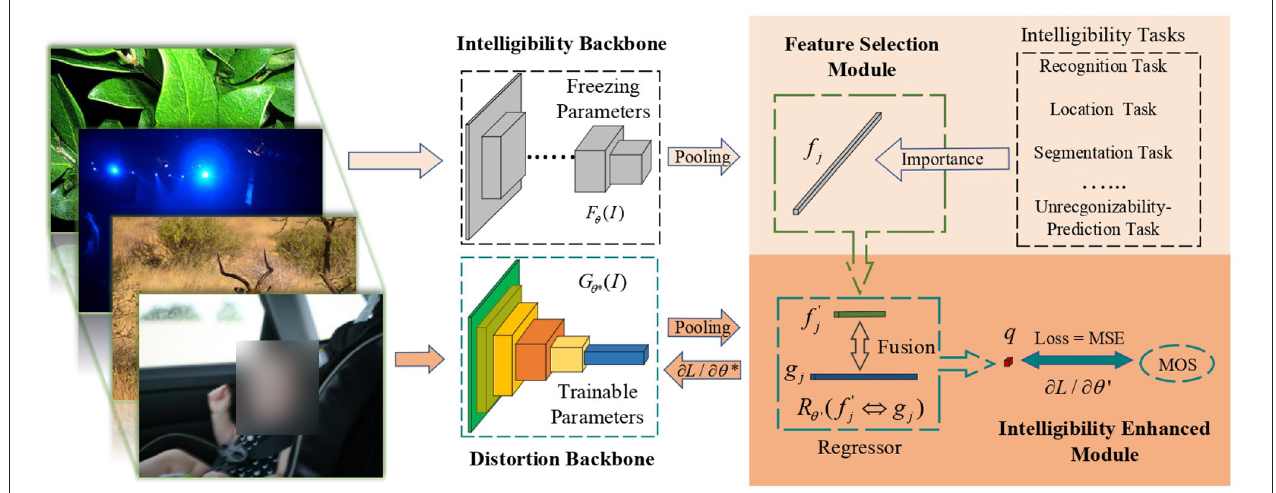
FIGURE 3 | Proposed framework of IE-IQA. Our framework contains intelligibility and distortion backbone, and colorful blocks in the distortion backbone are trainable while gray blocks in the intelligibility backbone are not trainable. An intelligibility enhanced module is adopted to fuse distortion features with intelligibility features obtained from the proposed feature selection